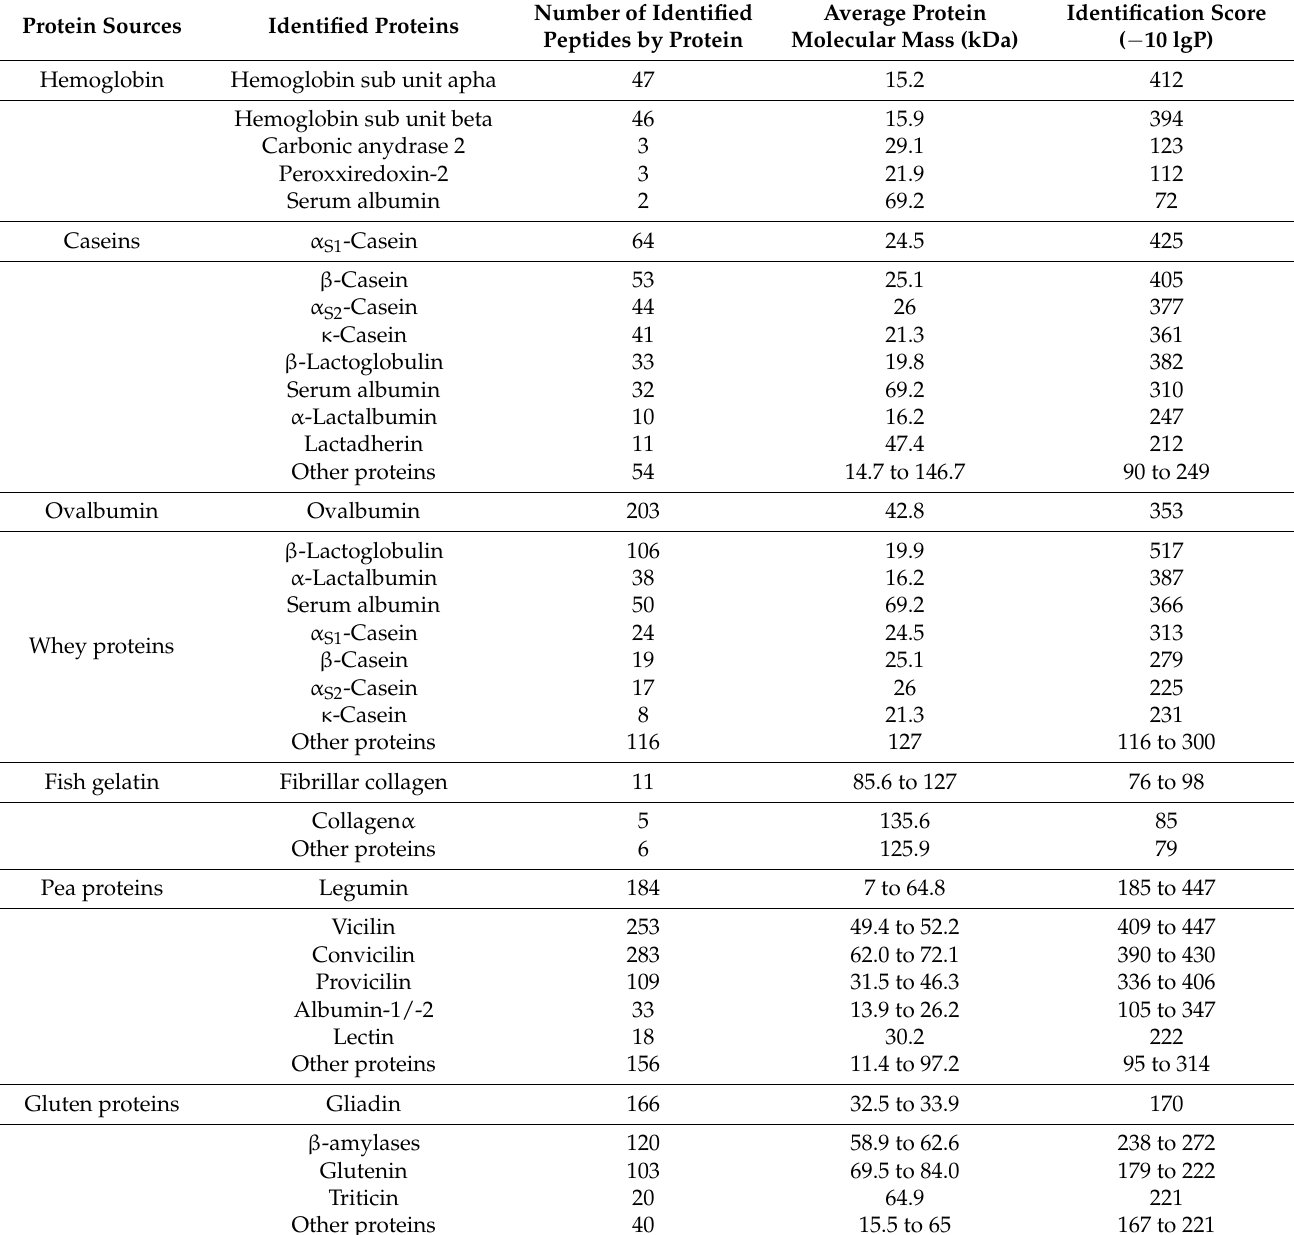
Table 1. Protein composition of the raw protein samples determined by proteomics